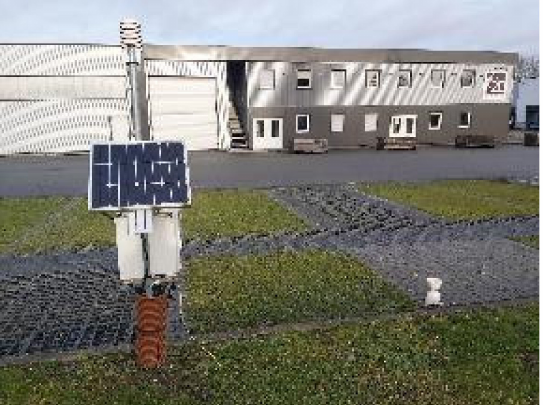
Figure 5. Data acquisition facility: outdoor temperature and relative humidity probe (CS215) on the left, rain gauge on the right